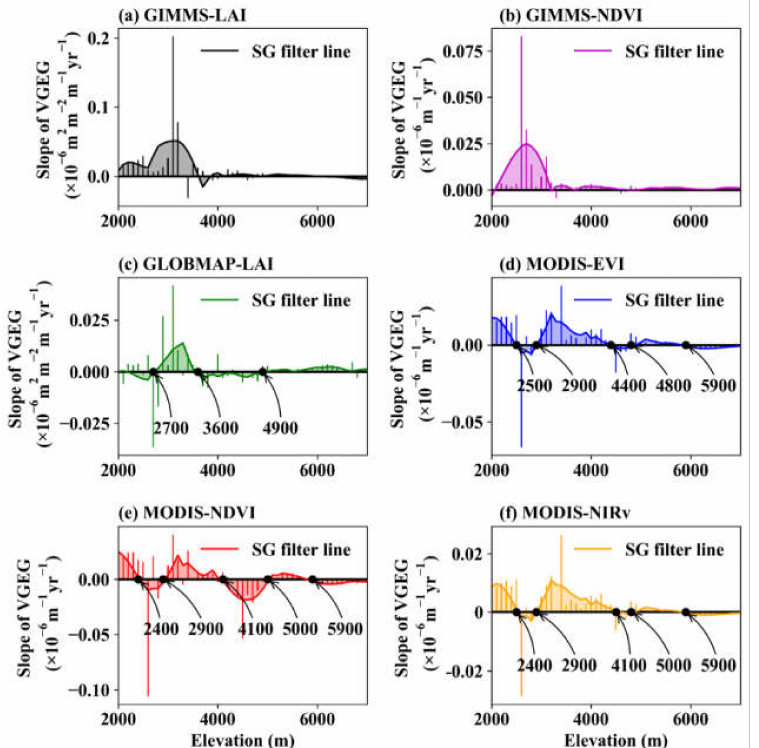
Figure A3. VGEG variation distributed in elevational gradients. The black circle denotes the turning elevation, and the solid line denotes the SG filter